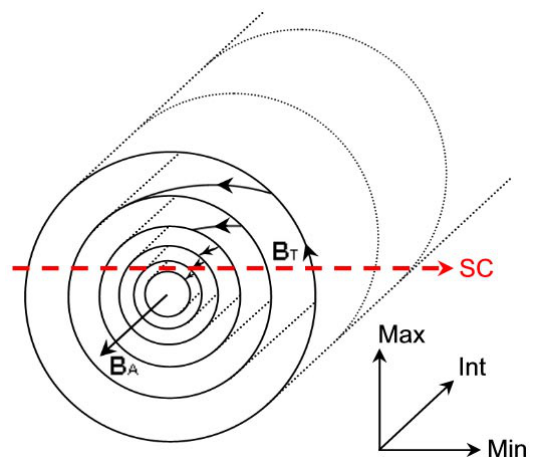
Fig. 1. The topology of a force-free helical flux rope. The strong axial and tangential magnetic field directions are marked. In the centre of the rope B T is zero, increasing to a maximum at the edge, whilst B A is maximal at the centre, falling to a minimum at the edge of the flux rope. A cartoon spacecraft trajectory is marked, along with the variance coordinate system that would arise from a constant α force-free flux